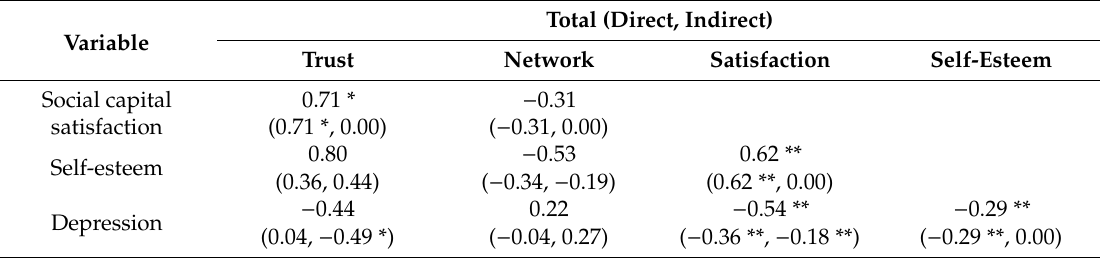
Table 5. Standardized coe ffi cients for the relationships between social capital (trust, network), social capital satisfaction, self-esteem, and